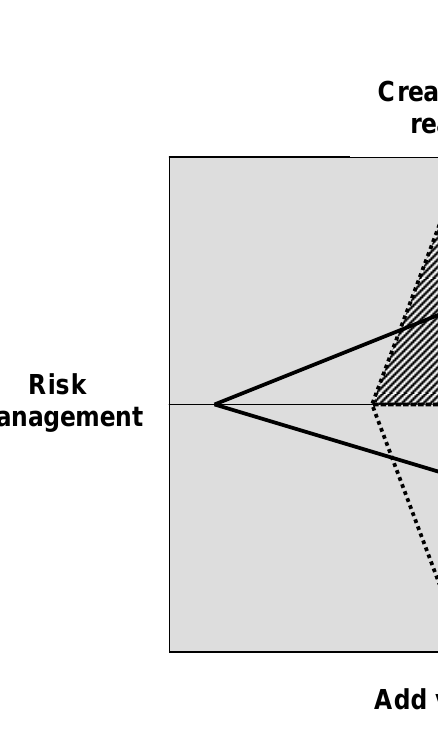
Source: Adapted from